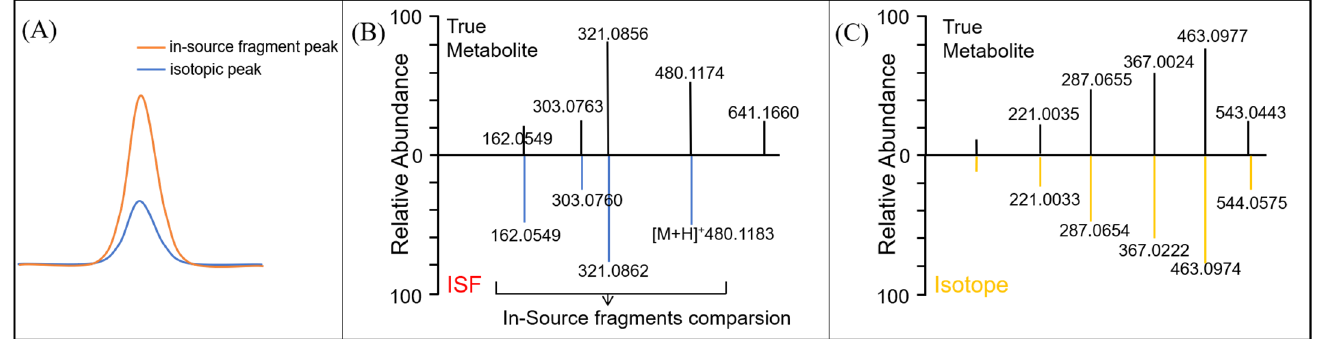
Figure 6. Identification of in-source fragmentation and isotopic peaks: ( A ) extracted ion chromatogram of in-source fragment or isotopic peaks; ( B ) fragment ions for M5 and its in-source fragmentation peak; ( C ) fragment ions for M1 and its isotopic peak.